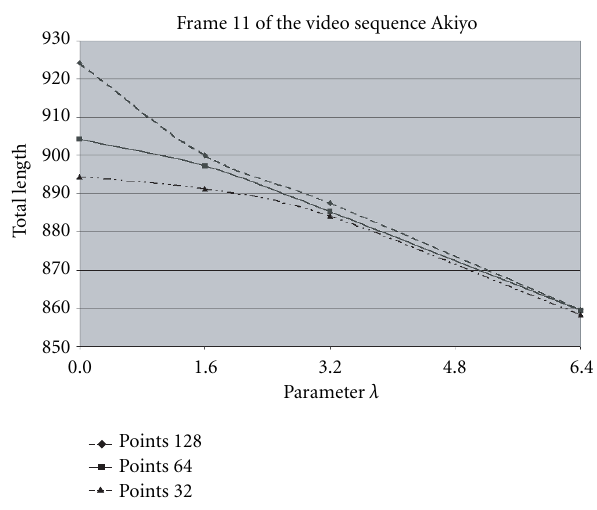
Figure 5: Average curve length over 50 frames (Akiyo sequence).